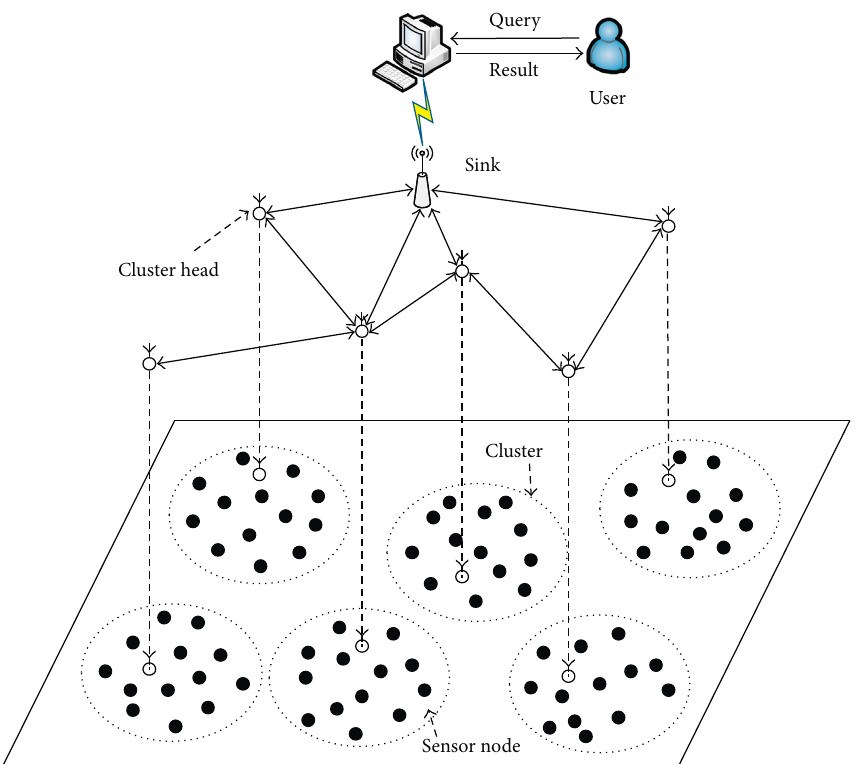
Figure 1: The cluster-based query processing scheme.